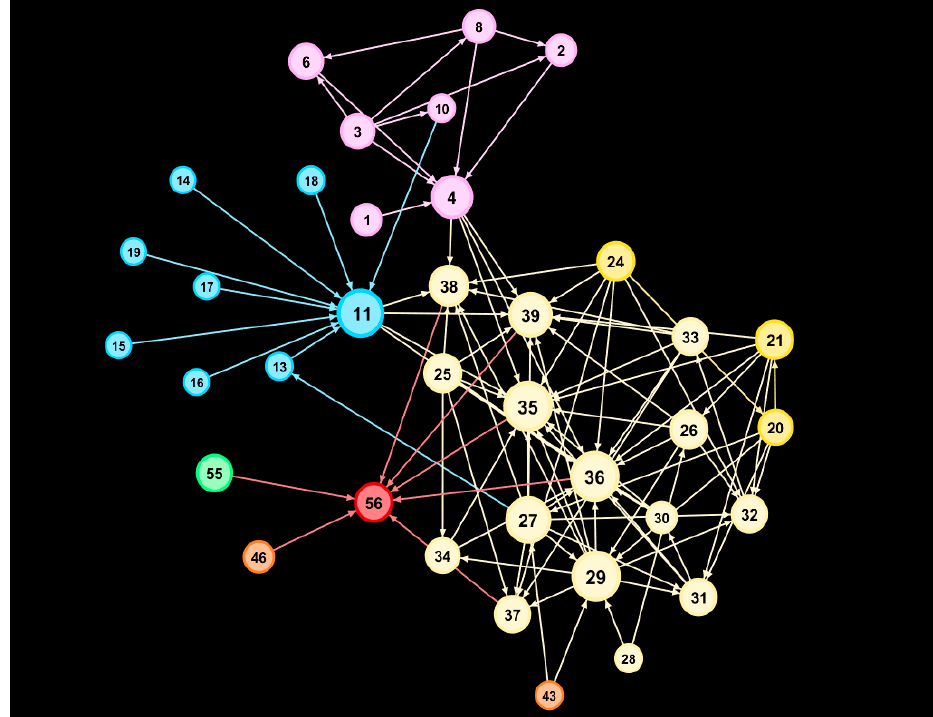
Figure 12. Node 56 and its level 1–3 node network diagram.